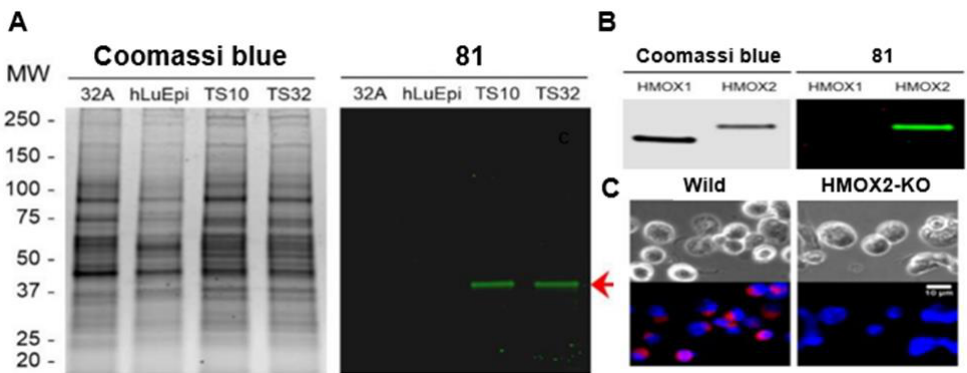
Figure 17. Target identification of dye 81 and therapeutic effects. ( A ) SDS-PAGE identified dye 81 in TS10 and TS32 cells. ( B ) SDS-PAGE analysis indicated the reaction of dye 81 with HMOX2. ( C ) Cell fluorescence images between wild type and HMOX2-KO cells. Figure used with permission from [32]. Copyright 2019 American Chemical Society.